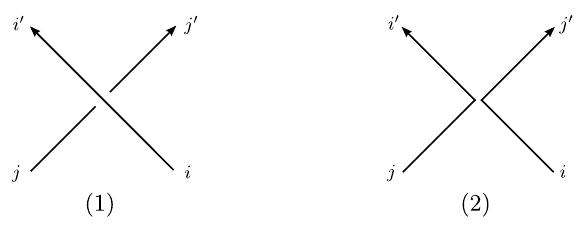
Figure 2 . Depiction of the contours C i and the associated color